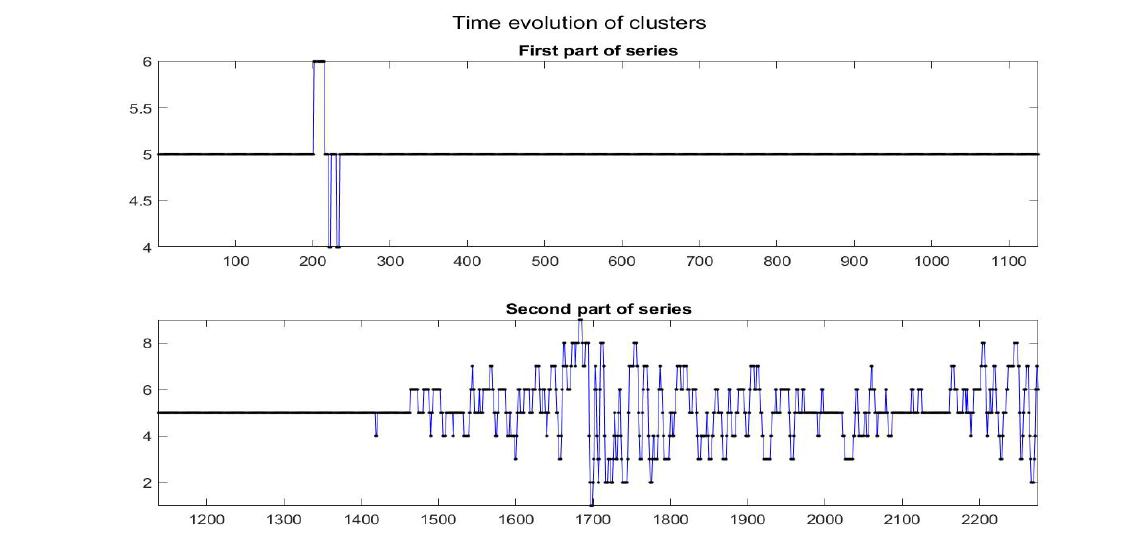
Figure 20. L 2 -norm modified iF-transform values f q series. The fuzzy r -partition is P a with r = 7.